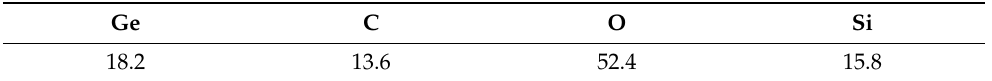
Table 1. Elemental composition of the layer obtained by co-evaporation of GeO 2 and SiO 2